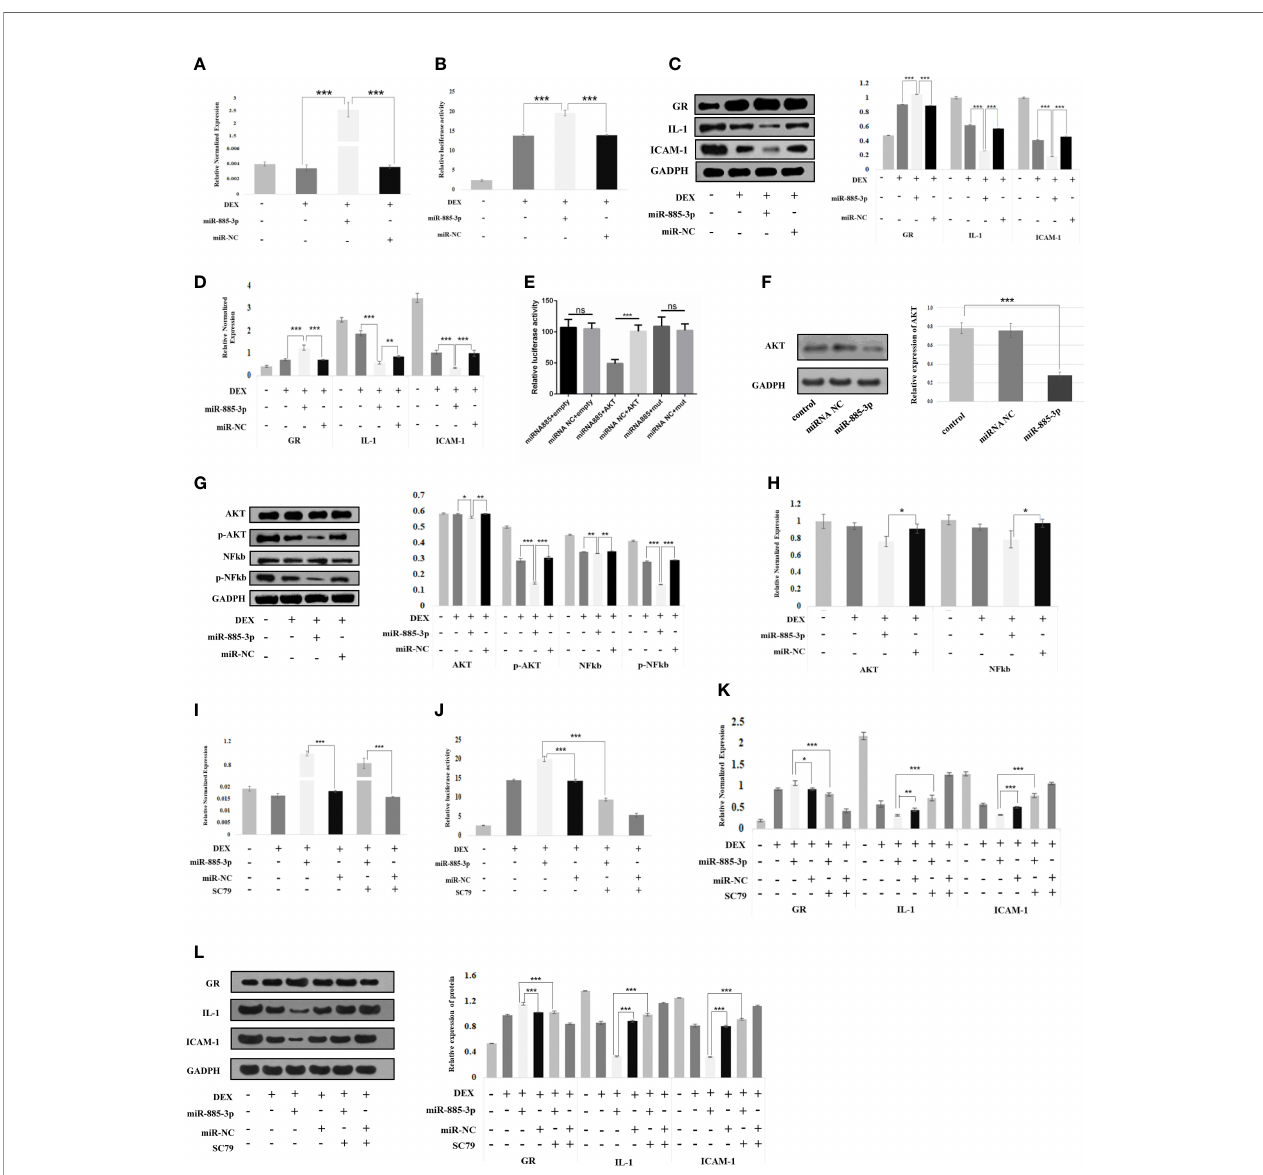
FIGURE 4 | Mir-885-3p regulated the glucocorticoid sensitivity of OFs by targeting AKT/NF k B. (A) Statistical chart of PCR detection of mir-885-3p in each group. DEX: 0.1 m m DEX-treated OFs for 24 h; miR-885-3p: miR-885-mic-treated OFs for 24 h; miR-NC: NC miRNA-treated OFs for 24 h; * p < 0.05; ** p < 0.01; *** p < 0.001. (B) Plasmid activity of GRE luciferase reporter gene results in each group; grouping and statistical methods are the same as in (A) . (C) Western blot detection of GR, IL-1, and ICAM-1 protein levels in each group; grouping and statistical methods are the same as in (A) . (D) Statistical chart of PCR detection of GR, IL-1, and ICAM-1 mRNA levels in each group; grouping and statistical methods are the same as in (A) . (E) The results of double luciferase in 293T cells; miRNA-885: miRNA-885-3p mimics co-transfected with plasmid; miRNA NC: corresponding NC miRNA co-transfected with plasmid; empty: co-transfected plasmid was empty; AKT: co-transfected plasmid was AKT2 3 ′ -UTR recombinant plasmid; mut: co-transfected plasmid was mut-AKT2 3 ′ -UTR recombinant plasmid; ns, no statistical signi fi cance; *** p < 0.001. (F) Western blot detection of AKT protein levels in each group; grouping and statistical methods are the same as in (A) . (G) Western blot detection of AKT, pAKT, NF k B, and pNF k B protein levels in each group; grouping and statistical methods are the same as in (A) . (H) Statistical chart of PCR detection of AKT and NF k B mRNA levels in each group; grouping and statistical methods are the same as in (A) . (I) Statistical chart of PCR detection of mir-885-3p in each group. DEX: 0.1 m m DEX-treated OFs for 24 h; miR-885-3p: miR-885-mic-treated OFs for 24 h; miR-NC: NC miRNA-treated OFs for 24 h; SC79: AKT agonist-treated OFs for 24 h; * p < 0.05; ** p < 0.01; *** p < 0.001. (J) Plasmid activity of GRE luciferase reporter gene results in each group; grouping and statistical methods are the same as in (I) . (K) Statistical chart of PCR detection of GR, IL-1, and ICAM-1 mRNA levels in each group; grouping and statistical methods are the same as in (I) . (L) Western blot detection of GR, IL-1, and ICAM-1 protein levels in each group; grouping and statistical methods are the same as in (I)